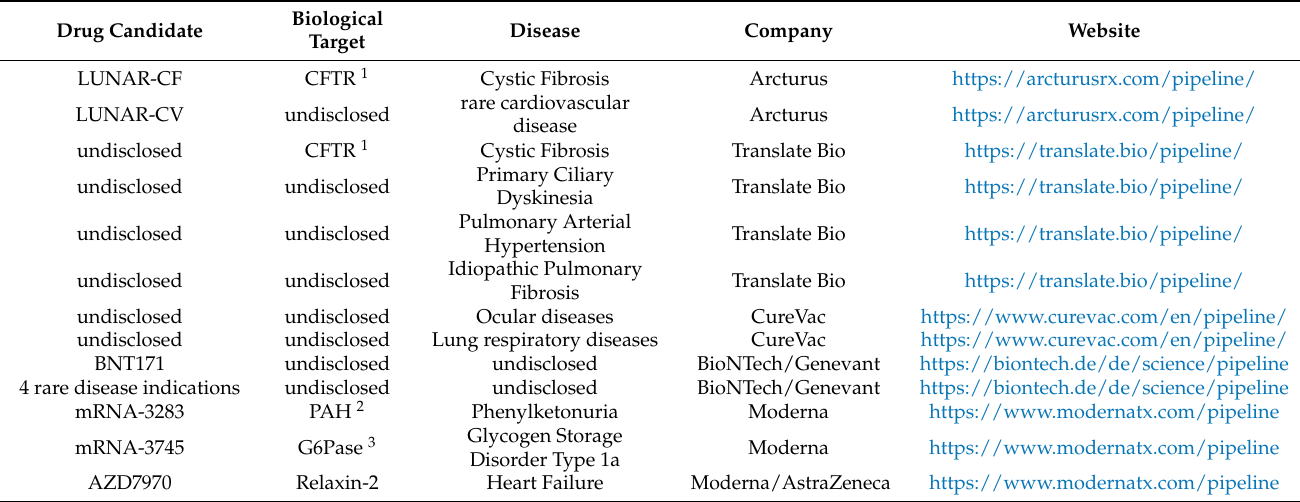
Table 4. LNP-mRNA-based protein replacement/rare disease industry preclinical